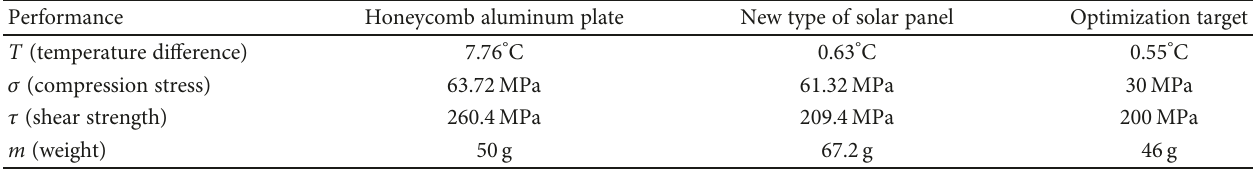
Table 6: Optimization target of the new type of solar panel.